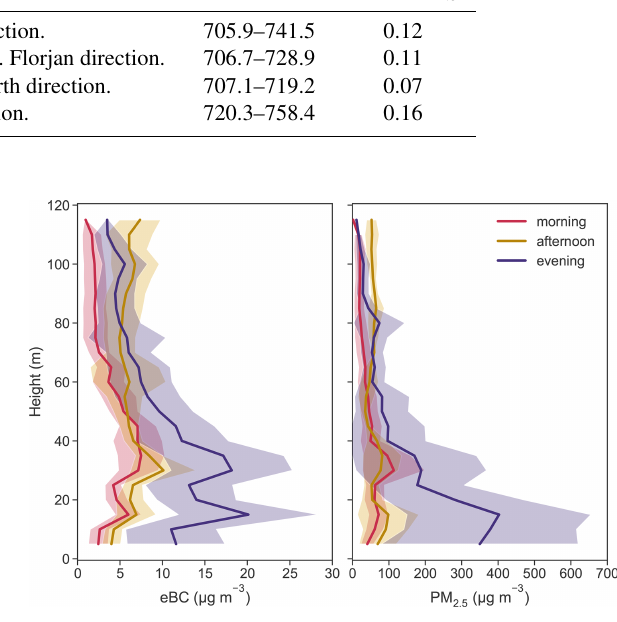
Figure 6. Mean vertical eBC and PM 2 . 5 profiles with stan- dard deviation (shaded area) during morning (06:30–08:30LT, red line), afternoon (12:00–14:00LT, yellow line), and evening (17:00– 19:00LT, purple line) winter-time temperature inversions over the Retje